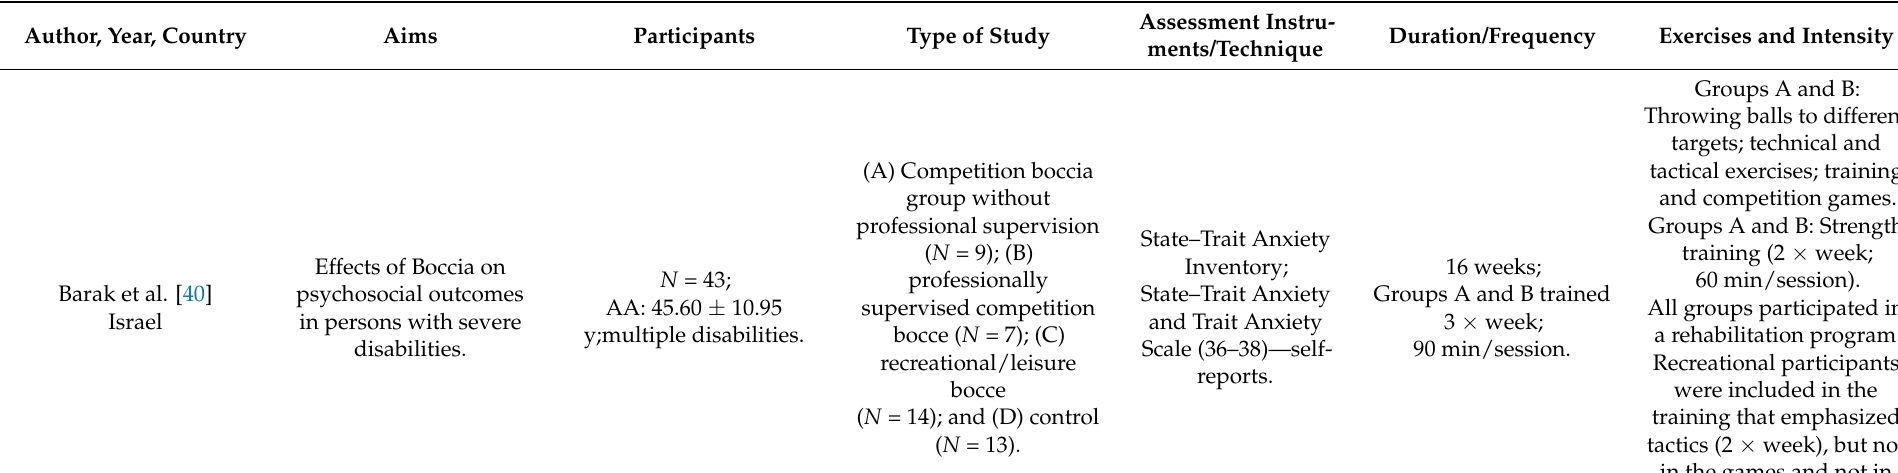
Table 2. Characteristics of the four